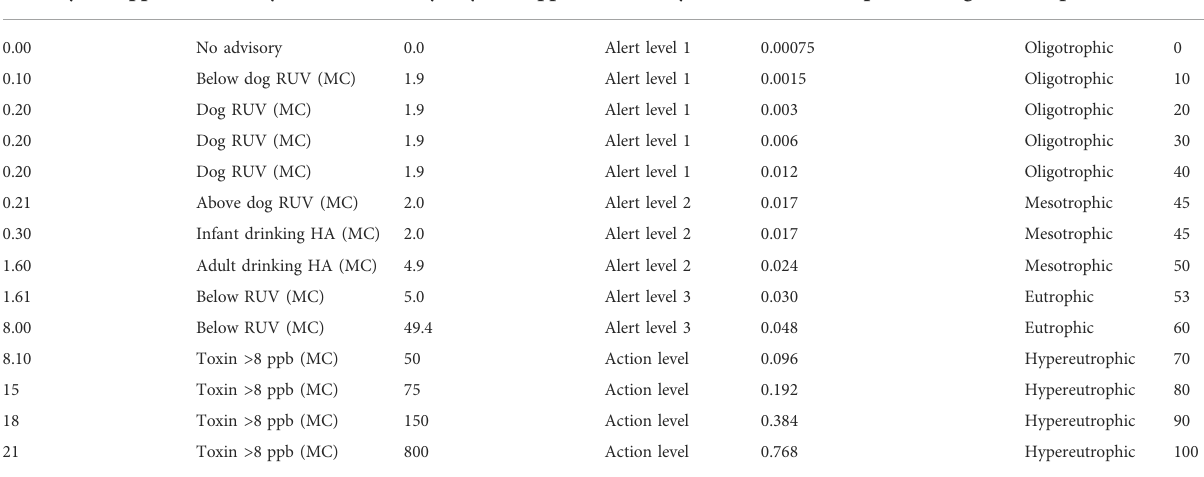
TABLE 1 Water quality index table with nomenclature to denote water quality based on concentration metrics for microcystin (MC), phycocyanin (PC),and phosphorus.This classi fi cation table is anexpansionof the TrophicState Index(TSI) table in Carlson (Carlson 1977) thatde fi ned a range of total phosphorus concentration in freshwater lakes as oligotrophic, mesotrophic, eutrophic, and hypereutrophic (healthy to unhealthy). MC and PC concentration ranges have been de fi ned here to create a more inclusive water quality index. The color bands denote water quality conditions relativetotoxinload.Microcystin(MC)toxinconcentrationvaluerangesfrom0.0 – 0.2 ppbareclassi fi edasDogrecreationalusevalue(DogRUV) (blue), 0.21 – 1.60 ppb are classi fi ed as Adult Drinking health advisory (HA) (green), 1.61 – 8 ppb are classi fi ed as below toxin RUV (yellow), and > 8ppb is Toxin > 8 ppb (orange) for MC. (EPA 820-R-15-100 (2015), EPA 822-R-10-001 (2019), Oregon Health Authority (2019). PC concentration ranges of 0 – 1.9 ppb (blue), 2.0 – 4.9 ppb (green), 5.0 – 49.4 ppb (yellow), and 49.41 – 800 ppb (orange) are denoted as Alert level 1, Alert level 2, Alert level 3, and Action level, respectively (Izydorczyk et al., 2009; Cotterill et al., 2019). Microcystin (ppb) Advisory